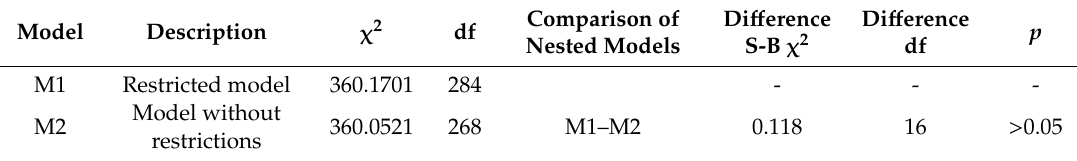
Table 4. Tests of measurement invariance across two samples for the two-factor model.